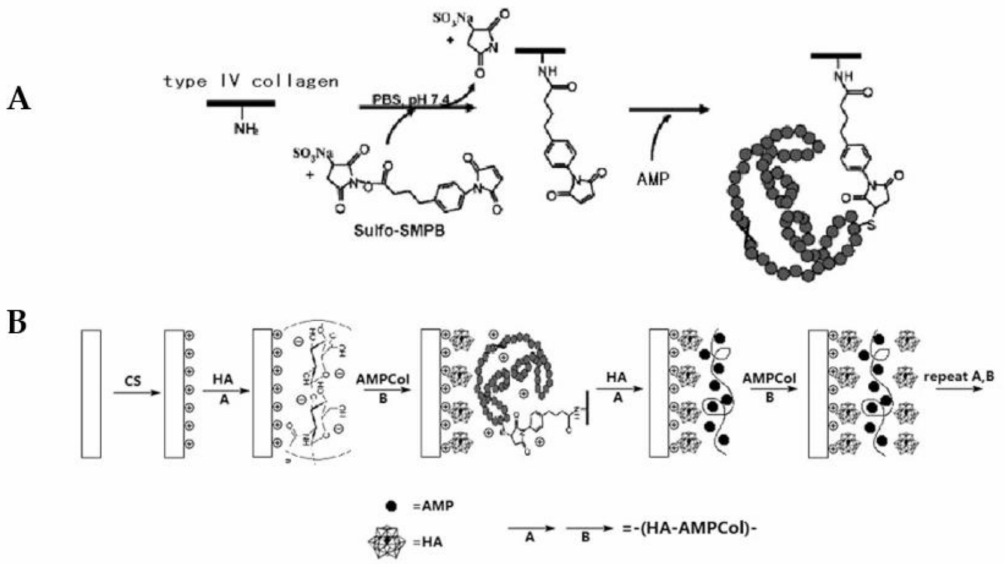
Figure 3. Schematic representation of Chitosan and Hyaluronic Acid Layer by layer coating production embedding an AMP-collagen IV conjugate. ( A ) Synthesis of AMPCol; ( B ) CS-(HA-AMPCol) layer by layer coating production. Adapted with permission from reference